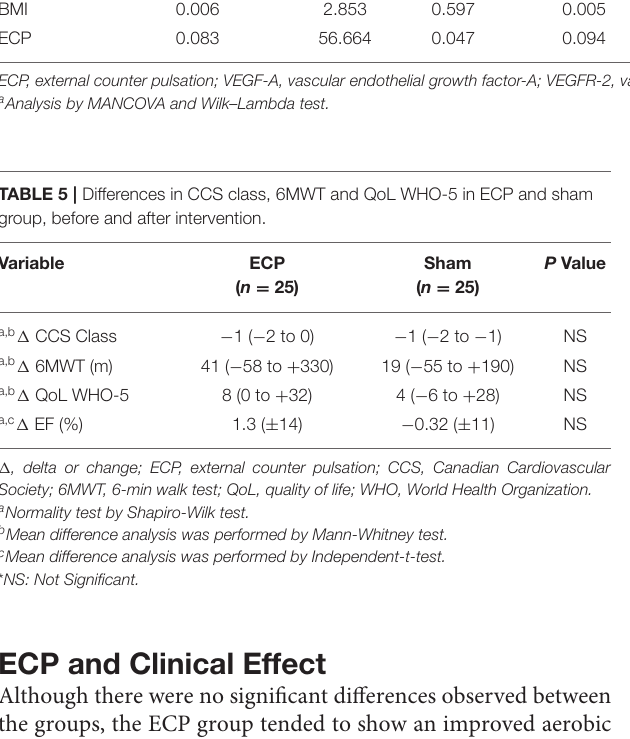
TABLE 3 | MicroRNA-92a expression in ECP group and sham group, before and after intervention. Variables ECP *miR-92a expression, before 5.1 ( + 4.2 to + 6.4) *miR-92a expression, after 5.9 ( + 4.8 to + 6.4)